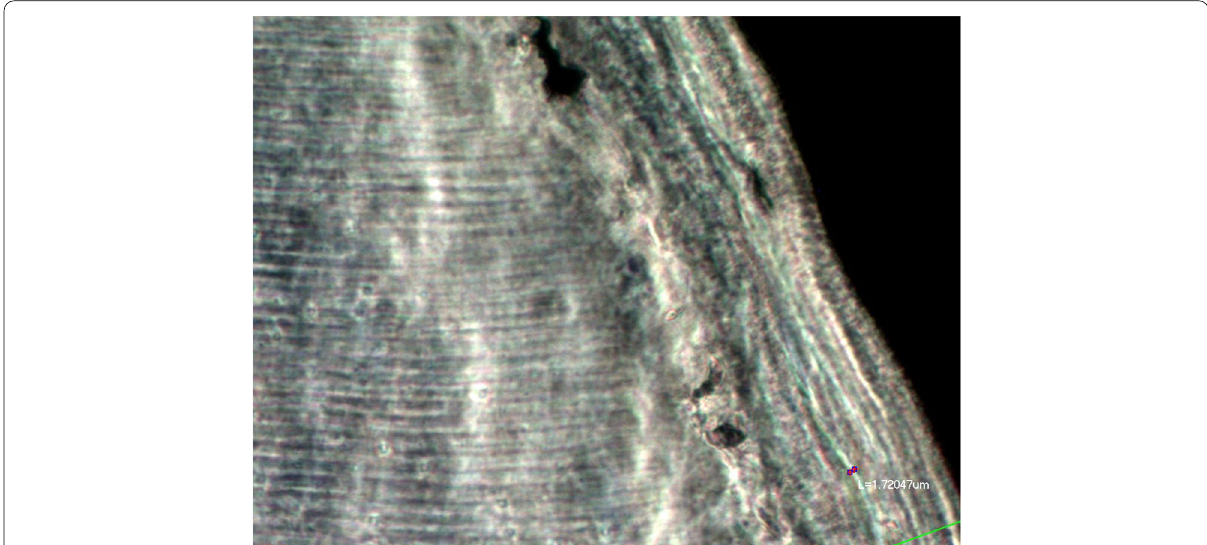
Fig. 3 Photomicrograph of normal tooth showing measurement of the width between two incremental lines of cementum (ground section